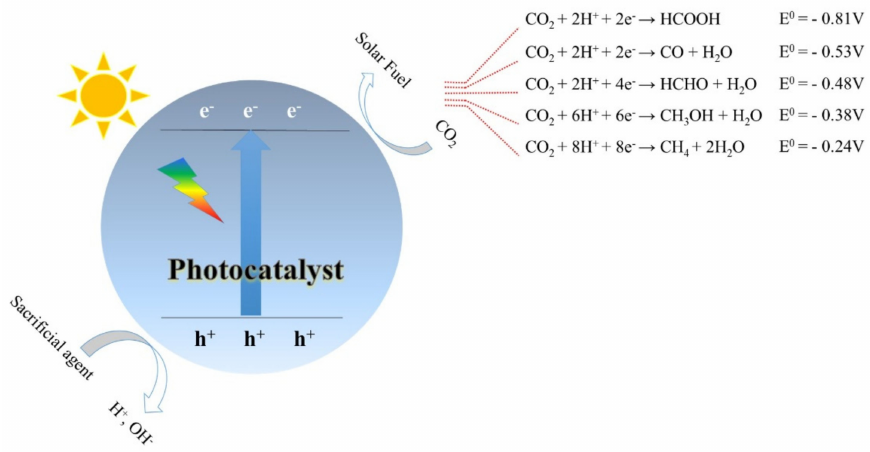
Figure 14. Schematic of the overall photocatalytic reaction process for CO 2 reduction (E + Potential (V) vs. NHE at pH